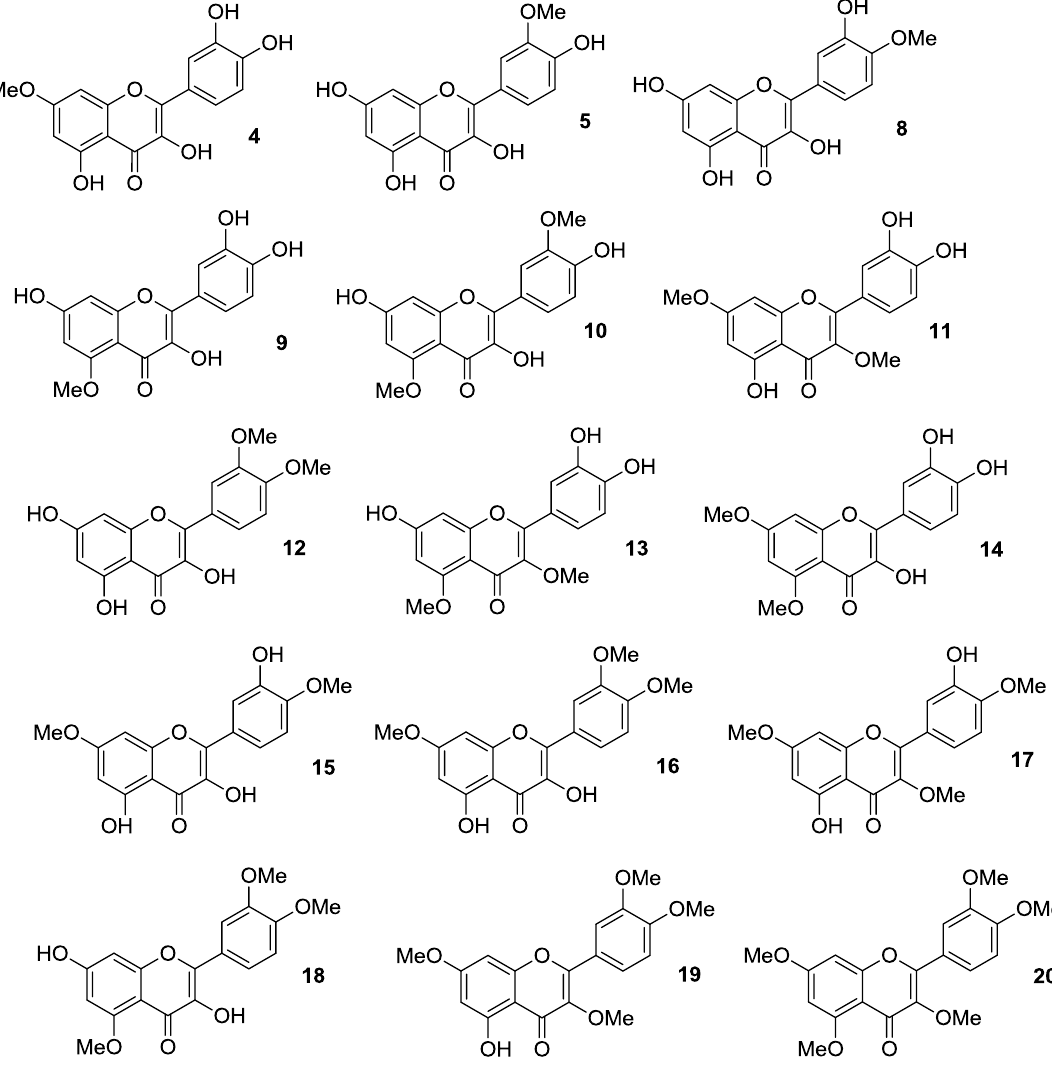
Figure 4. Structures of O -methylated quercetin derivatives ( 4 ), ( 5 ), and ( 8 – 20 ).